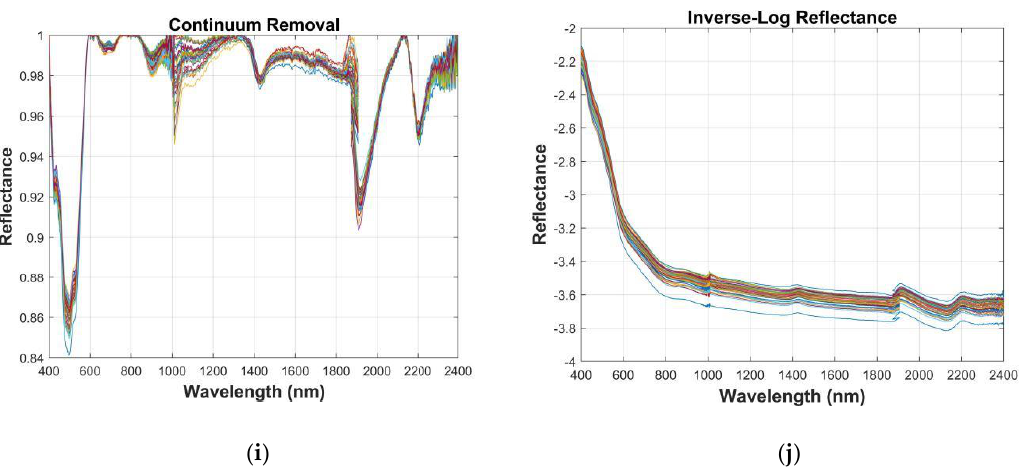
Figure 4. Soil pretreatment under different spectral indices (Honghu): ( a ) multiplicative scatter correction (MSC), ( b ) mean centering (MC), ( c ) moving average (MA), ( d ) Savitzky–Golay (SG), ( e ) first derivative after Savitzky–Golay (SG-FD), ( f ) second derivative after Savitzky–Golay (SG-SD), ( g ) first derivative (FD), ( h ) second derivative (SD), ( i ) continuum removal (CR), and ( j ) inverse-log reflectance (Log(1/R)). Sensors 2020 , 20 , x FOR PEER REVIEW